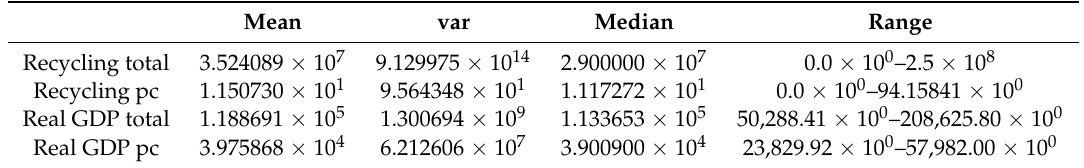
Table A3. Descriptive Statistics of the data for Middle Poor